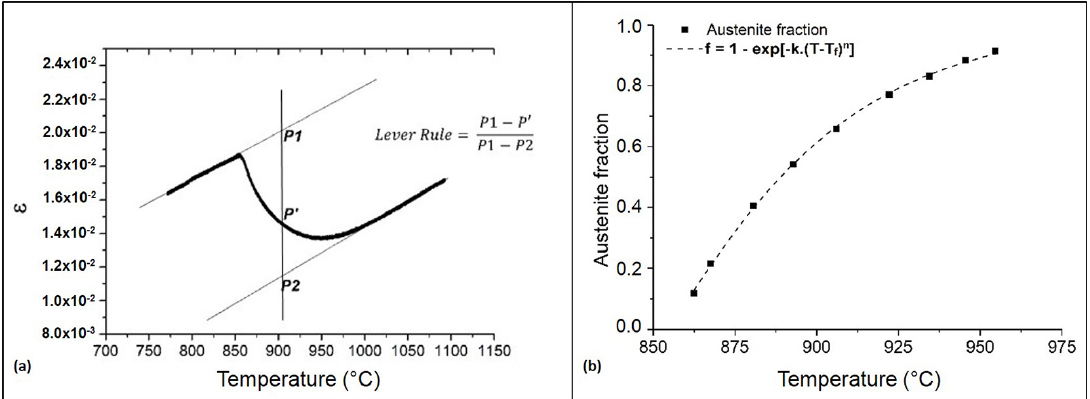
Figure 5. (a) Schematic figure presenting the applied method to calculate the austenite fraction (lever rule); (b) austenite fraction as a temperature function during steel continuous cooling at 0.5 o